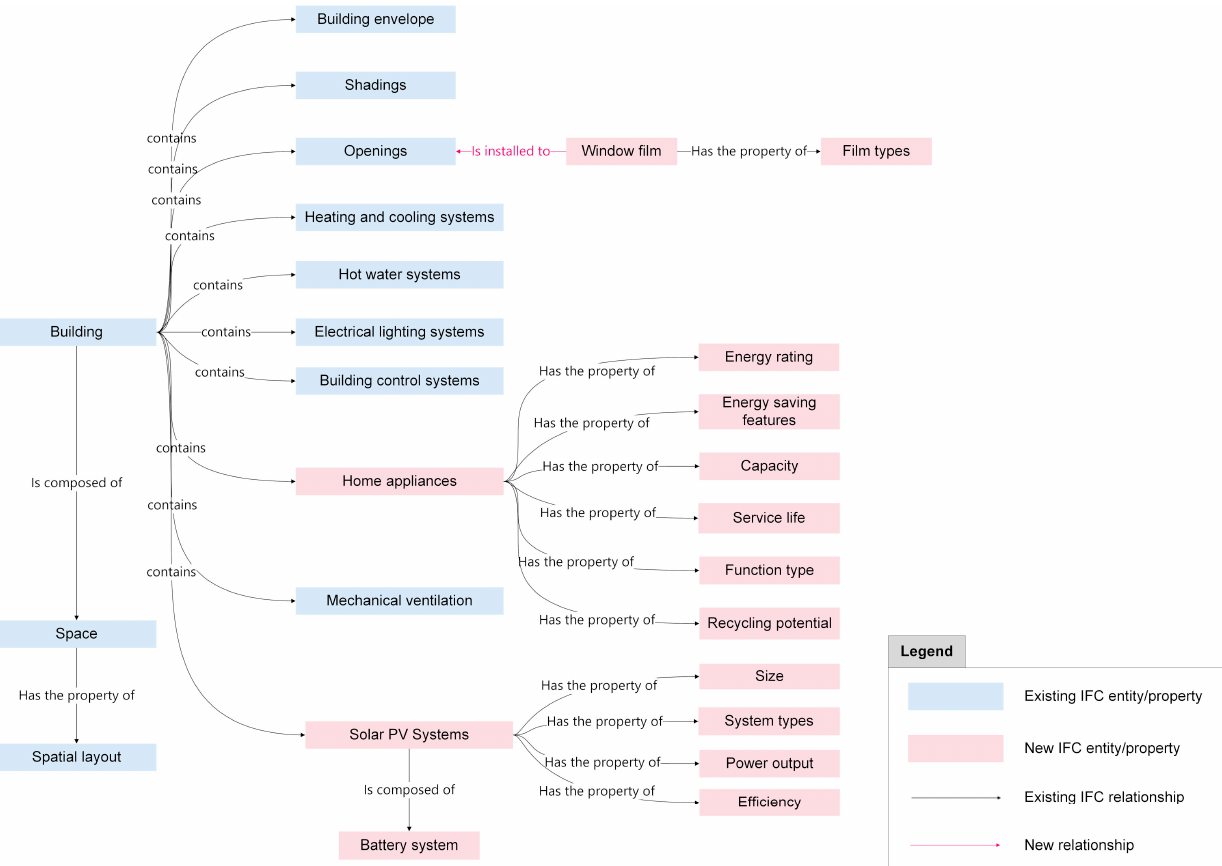
Figure 13. Illustration of an extension of additional entities, properties, and relationships to represent key decision variables affecting net-zero-carbon building outcomes at design stage, and the links to the existing IFC entities.